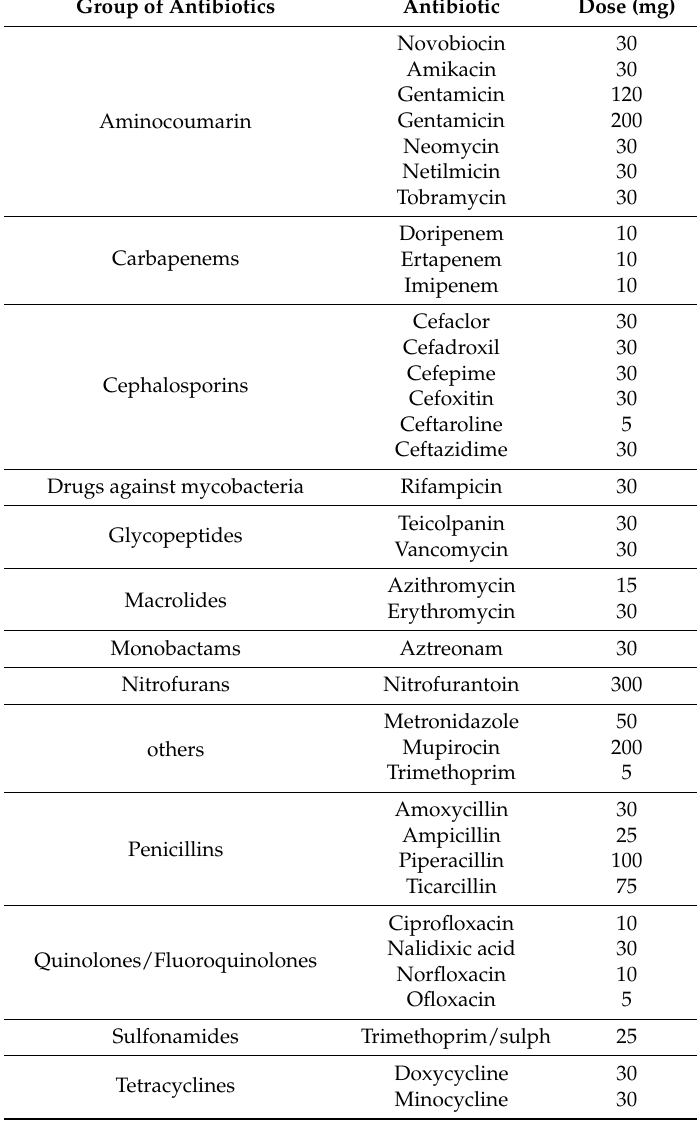
Table 2. Antibiotics used in susceptibility